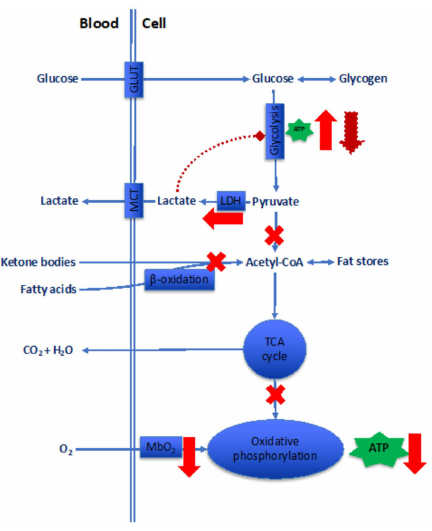
Figure 5. Scheme of the ATP production paths. In normoxia, most of the ATP is produced aerobically with a stringent need for O 2 during oxidative phosphorylation, which follows the tricarboxylic acid (TCA) cycle. The utilization of O 2 is helped by the presence of myoglobin (Mb) in contractile tissues. The oxidizable substrates that most contribute to aerobic ATP production are glucose, fatty acids, and (in heart and brain) ketone bodies. In acute hypoxia (red arrows and crosses), the O 2 supply to oxidative phosphorylation is reduced along with the aerobic ATP production. Reduced disposal of acetyl-CoA by the TCA cycle, which is inhibited by hypoxia because of the hypoxia-induced downregulation of oxidative phosphorylation, in turn blocks the utilization of fatty acids (and ketone bodies in heart and brain). Simultaneous stimulation of glycolysis transiently increases anaerobic ATP production from glucose at the cost of increased lactate synthesis as partial compensation for the depressed aerobic ATP production. For longer hypoxia (brown dotted line), lactate overproduction is not compensated by proportional upregulation of the monocarboxylate transporters (MCT) at least in contractile tissues (see Section 3.1.4 Lactate shuttle). This leads to intracellular lactate buildup with lactate-driven inhibition of the glycolytic flux and impairment of anaerobic ATP